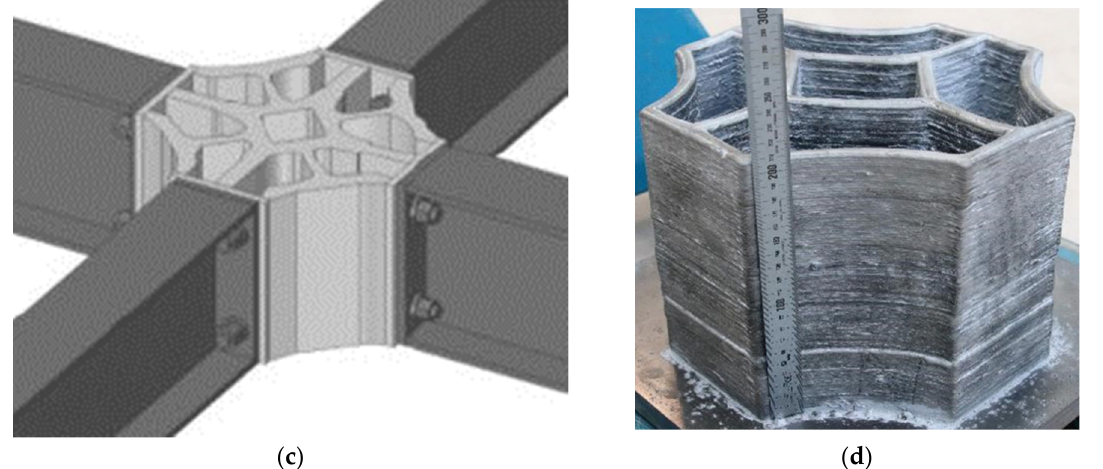
Figure 6. Topological Optimization of steel connections [67,68]: ( a ) Original bolt connection ( b ) AM-fabricated hook as replacement ( c ) 3D model of optimized node ( d ) AM-fabricated node that can connect four members. Copyright 2019 Copyright Ernst & Sohn Verlag für Architektur und technische Wissenschaften GmbH & Co. KG, Berlin; Copyright 2021 Copyright Ernst & Sohn Verlag für Architektur und technische Wissenschaften GmbH & Co. KG, Berlin.